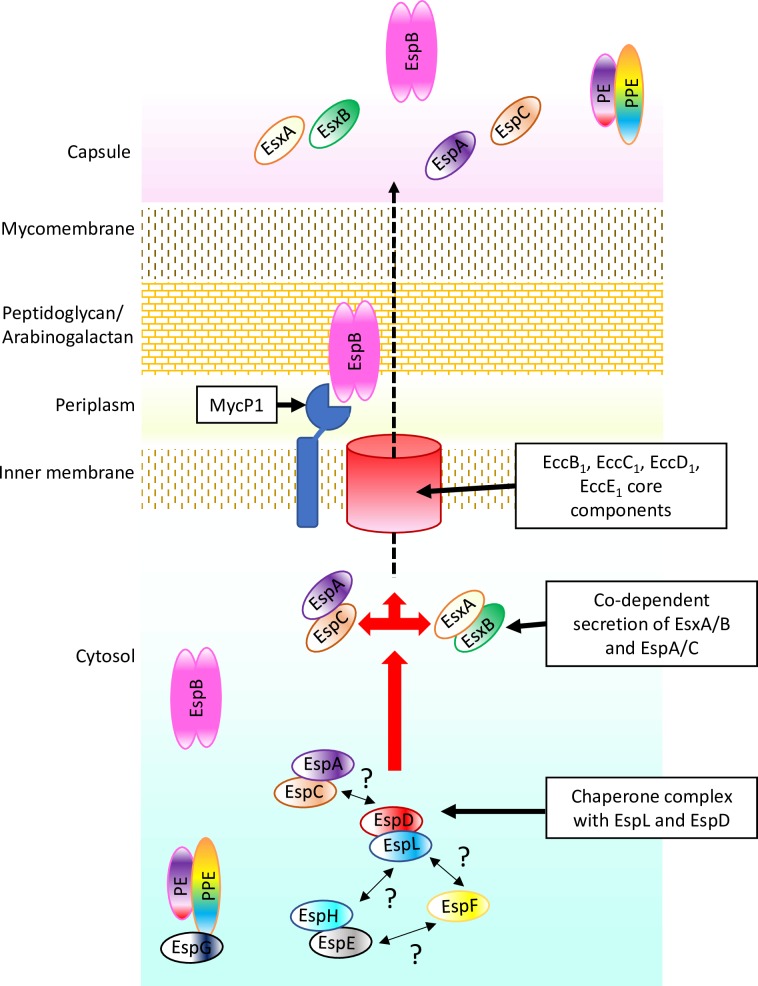
Proposed model for ESX-1-dependent secretion.In this model EspL forms a chaperone complex with EspD and this in turn stabilizes the EspA-EspC, EspE-EspH dimers and EspF. The chaperone complex may target EspA-EspC to the secretion machinery in the inner membrane, where co-dependent secretion with EsxA-EsxB takes place. Question marks indicate hypothetical protein-protein interactions. Not drawn to scale.